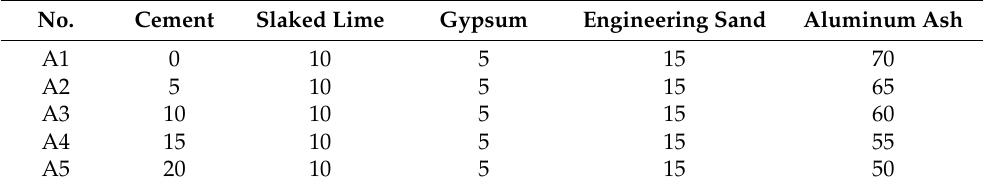
Table 2. Cement and aluminum ash mix design. (wt.%).